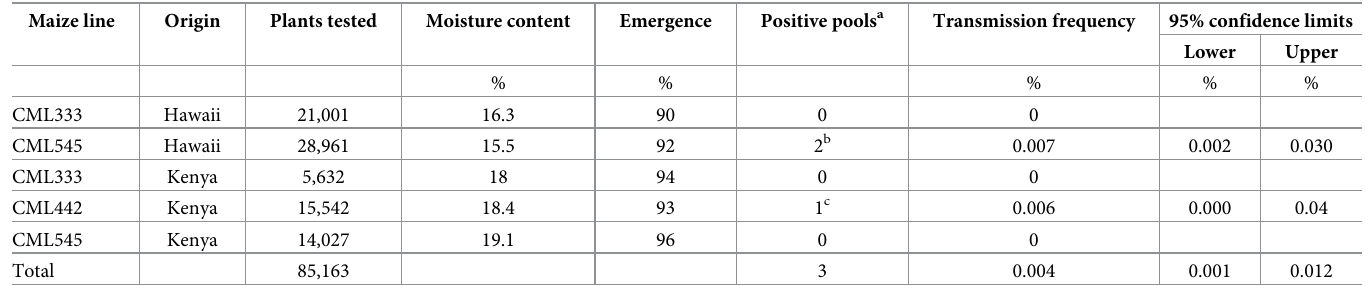
Table 1. Maize chlorotic mottle virus transmission from infested seed lots collected from Hawaii and Kenya. Maize